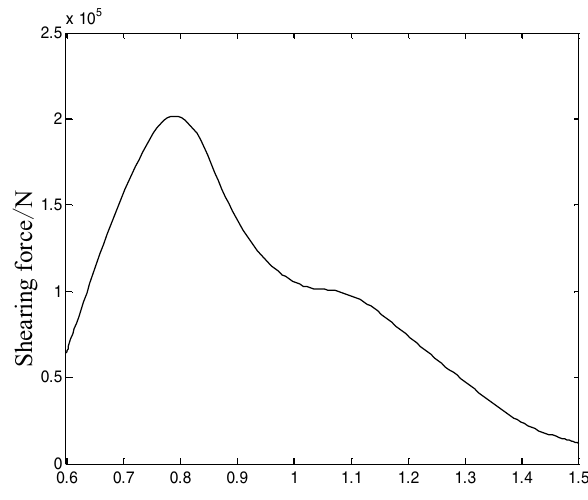
Fig. 10 Influence of wave frequency on the maximum shear force in the bridge girder